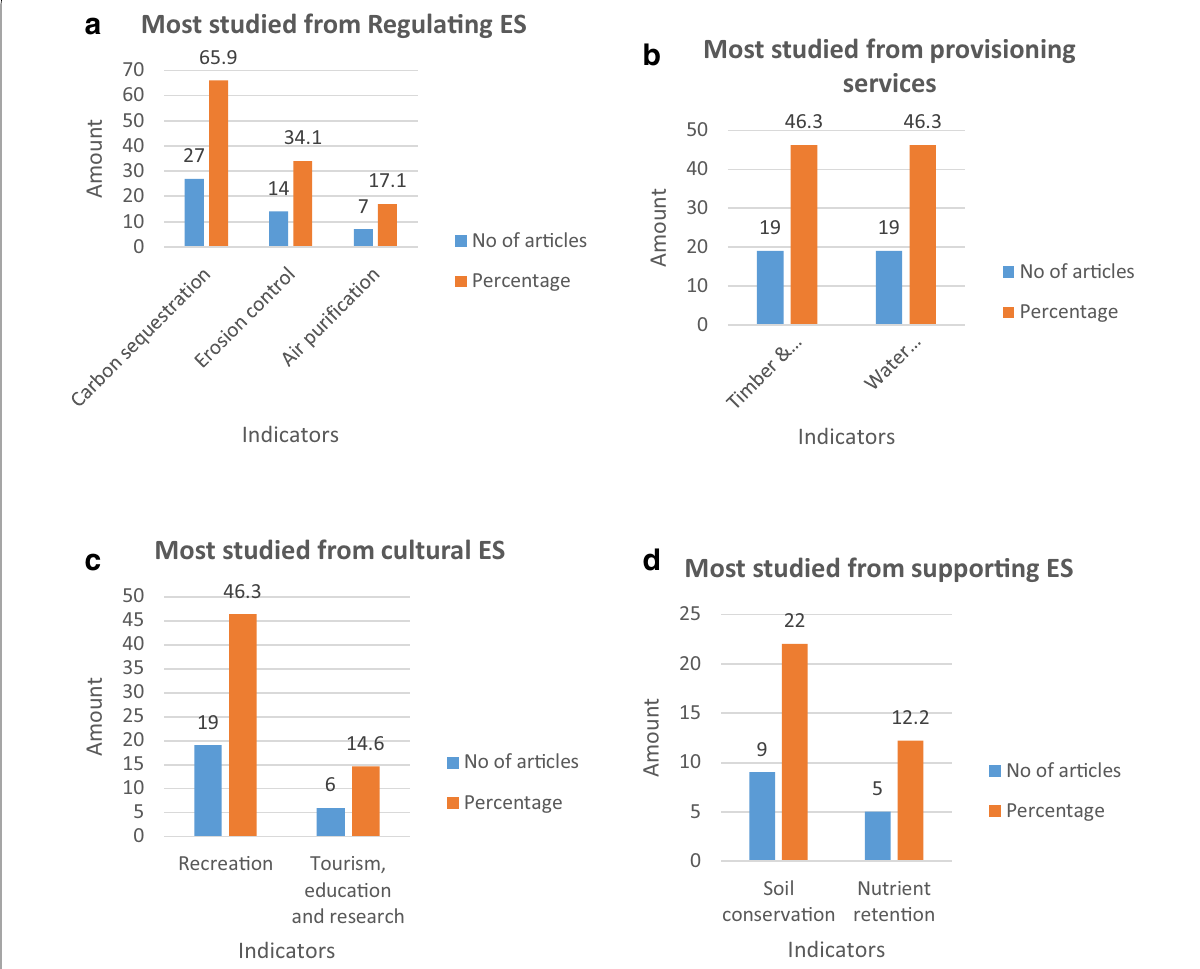
Fig. 8 Most common FES investigated from the selected reviewed literature. Using the final list of articles, the most common forest ecosystem services well studied were described. Majority of the work concentrated on regulating (carbon sequestration, erosion control), provisioning services (timber production and water supply) and recreation from cultural ecosystem